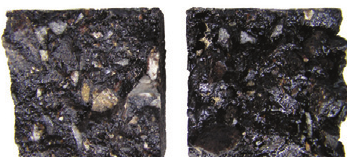
Fig. 8. AC 16 asphalt mixture with 100% degree of compaction (top) and AC 16 asphalt mixture with 97% degree of compaction (bottom)